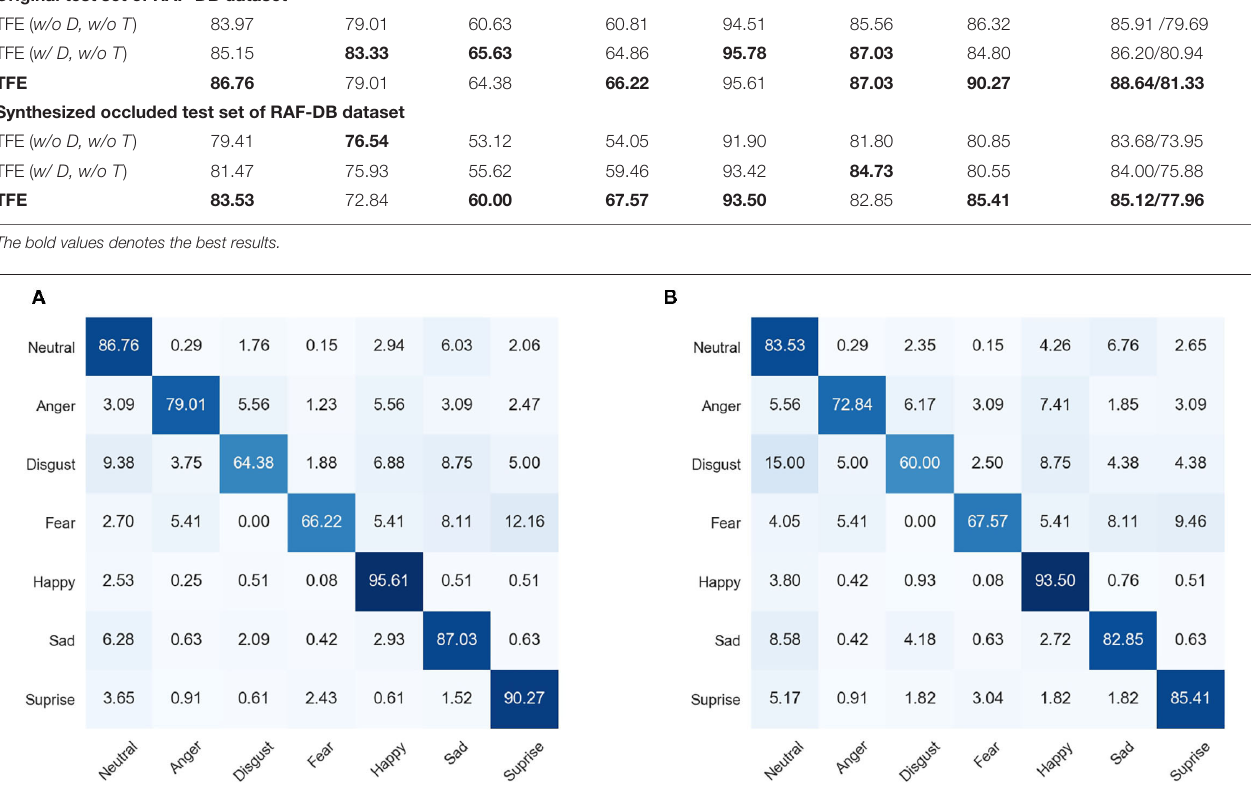
FIGURE 4 | Confusion matrixes of TFE. (A) Denotes the confusion matrix for the original test set of RAF-DB. (B) Is the confusion matrix for the synthesized occluded test set of RAF-DB. It is clear that TFE shows decreased performance on most of the facial expression categories with the manually occluders in the facial images. in the average accuracy. Compared with the